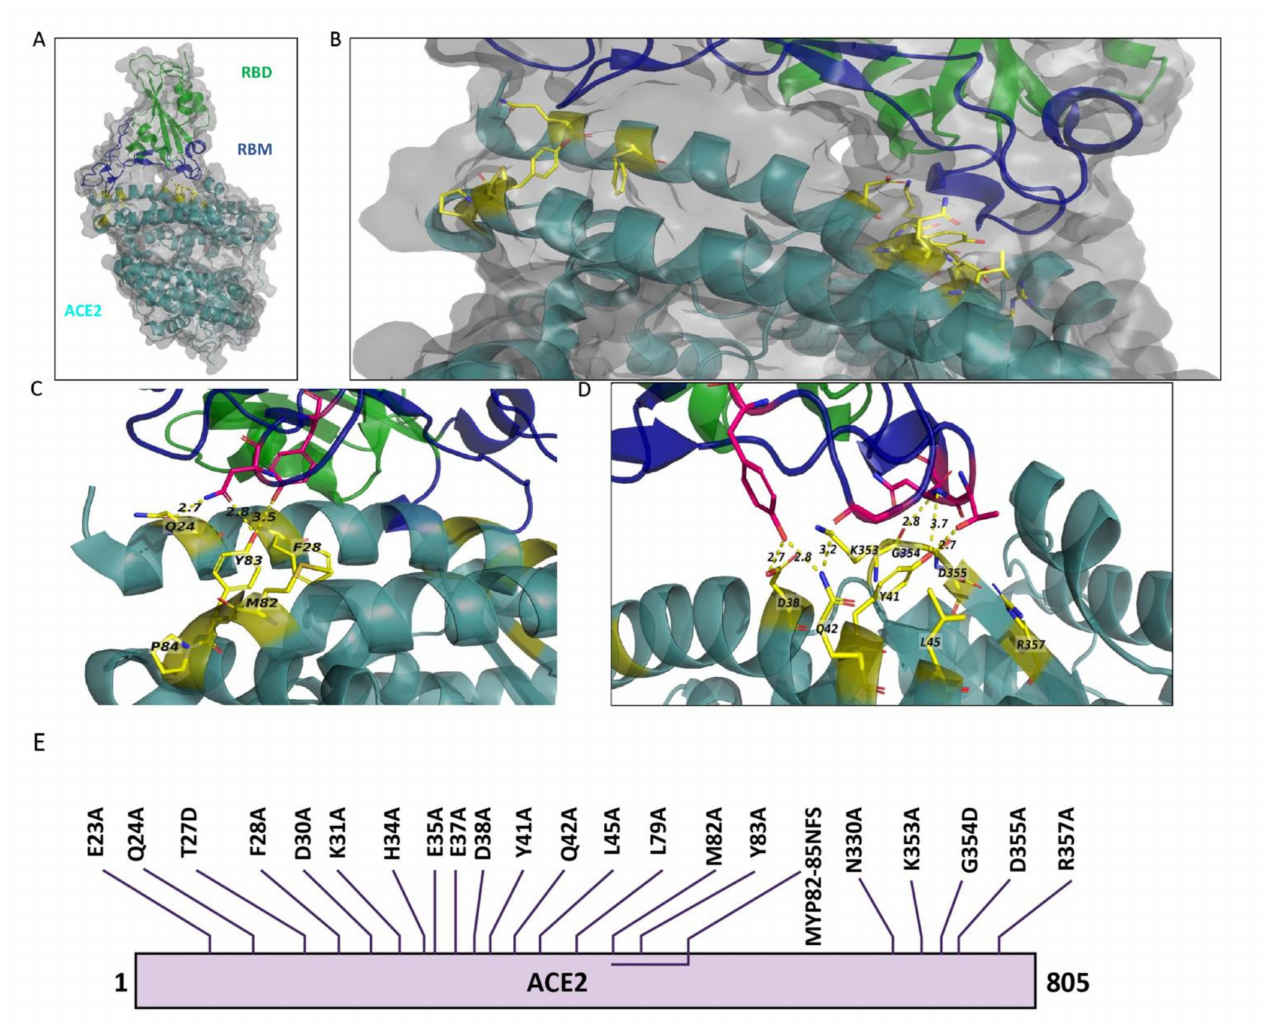
Figure 2. ACE2 amino acids in 3D structure of the bound RBD and ACE2 and schematic representation of mutations in ACE2. ( A ) 3D illustration of the overall structure of RBD bound to ACE2. RBD is colored in green, receptor-binding motif (RBM) of RBD is in dark blue, and ACE2 is in dark cyan. ( B ) Enlarged view of the overall structure depicting ACE2 target mutation sites in stick rendition. Sticks are represented in yellow color. ( C , D ) ACE2 target mutation sites in stick representation at the contact site of two molecules. Dotted lines connect the mutant AAs to their contacting AAs in RBM. The structure is from PDB: 6M0J based on the information provided in Lan et al., 2020. ( E ) Illustration of the amino acid changes used to examine ACE2 in this